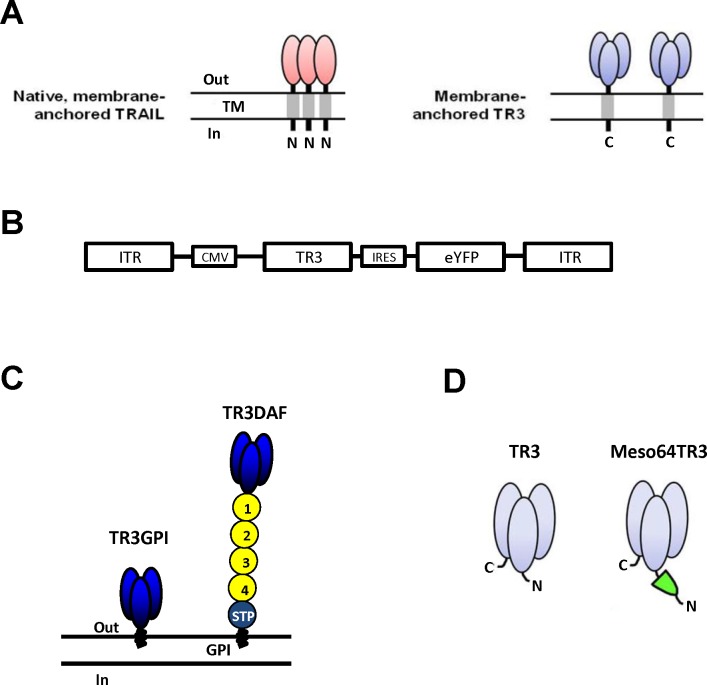
Schematic representation of native TRAIL and recombinant TR3 variants used in this study.(A) Illustration of the key structural features of wild-type, native TRAIL and a recombinant TR3 form anchored to the membrane via carboxyl-terminal incorporation of a transmembrane domain (TR3-TM). Please note the vastly different domain architecture/stoichiometry of the trimers between TRAIL (1:1) and TR3-TM (1:3). (B) Bicistronic adenoviral vector design in which TR3 expression correlates with the expression level of yellow fluorescent protein (eYFP) via Internal Ribosome Entry Site (IRES)-mediated cotranslation of the mRNA. (C) Schematic representation of two membrane-anchored TR3 variants are depicted: TR3GPI, in which the GPI-encoding sequence of human DAF servers as anchors signal and TR3DAF, in which the entire mature form of human DAF serves as an anchor unit. The short consensus repeats (SCRs) of DAF are indicated (1–4) and serve as a molecular spacer relative to the plasma membrane. (D) Secreted variants TR3 (parental) and Meso64TR3 are shown, the latter representing a MUC16-targeted TR3 trimer, in which only the 64 amino-terminal amino acids of mesothelin were used as delivery moiety to the MUC16 biomarker (including an N-terminal FLAG tag, not shown).